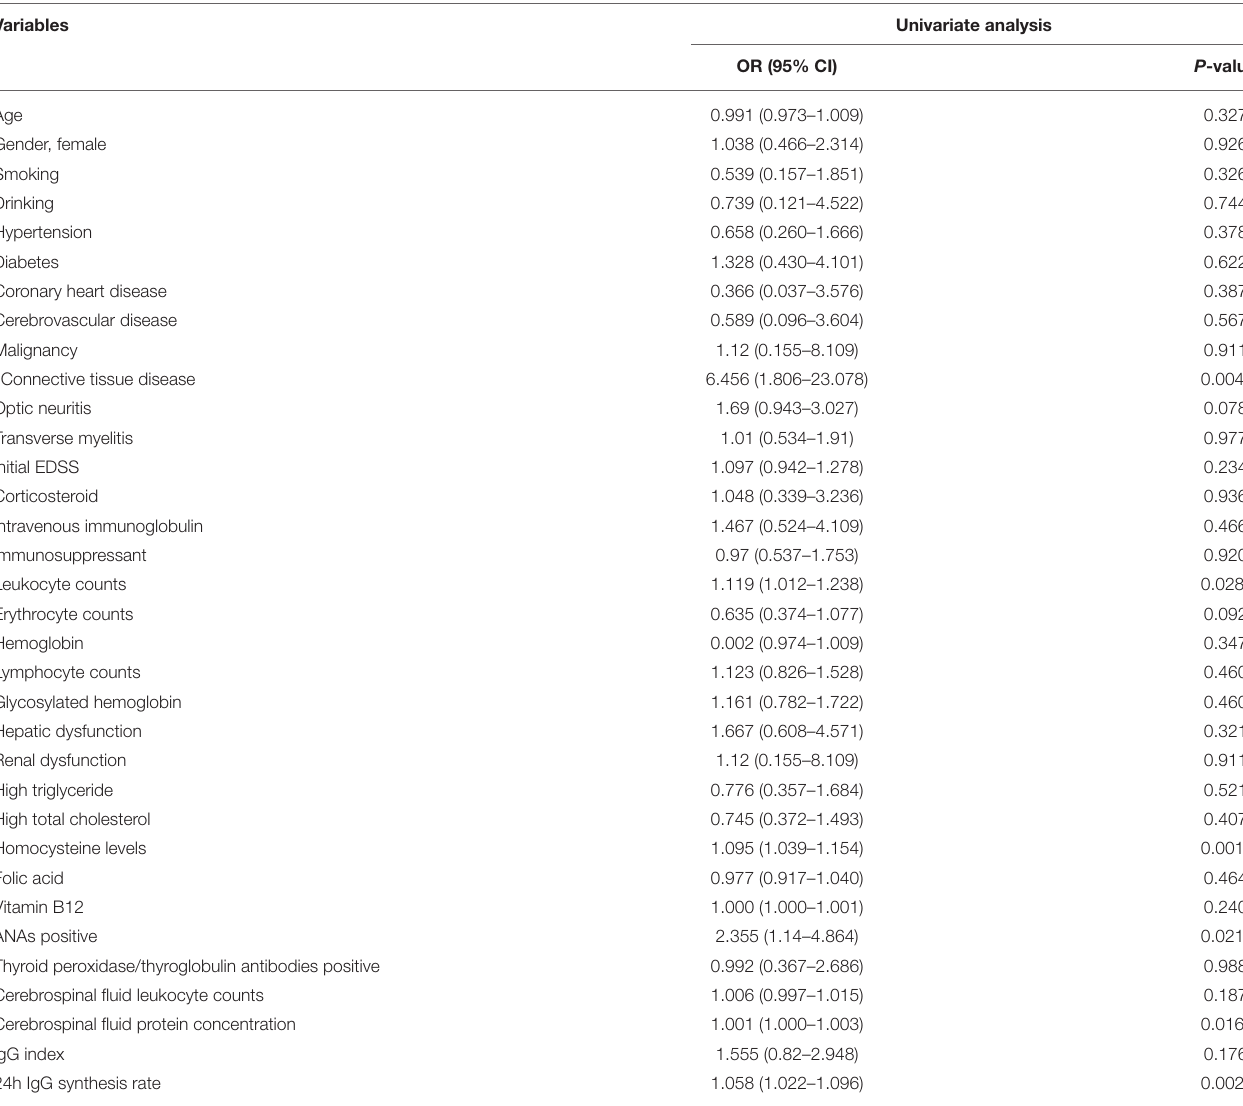
TABLE 3 | Univariate logistic regression analysis of potential risk factors that may predict high relapse events in patients with